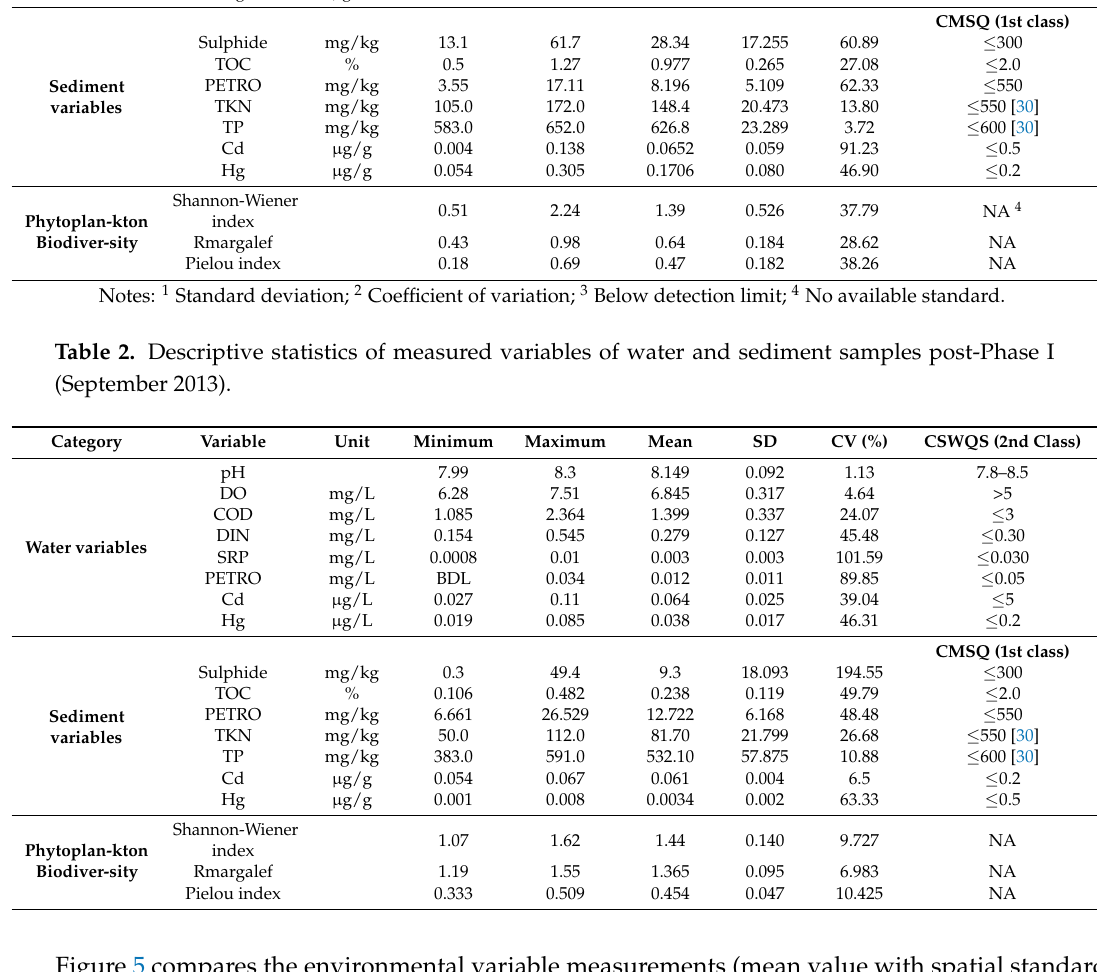
Table 1. Descriptive statistics of measured variables of water and sediment samples pre-Phase I (April 2010). Category Variable